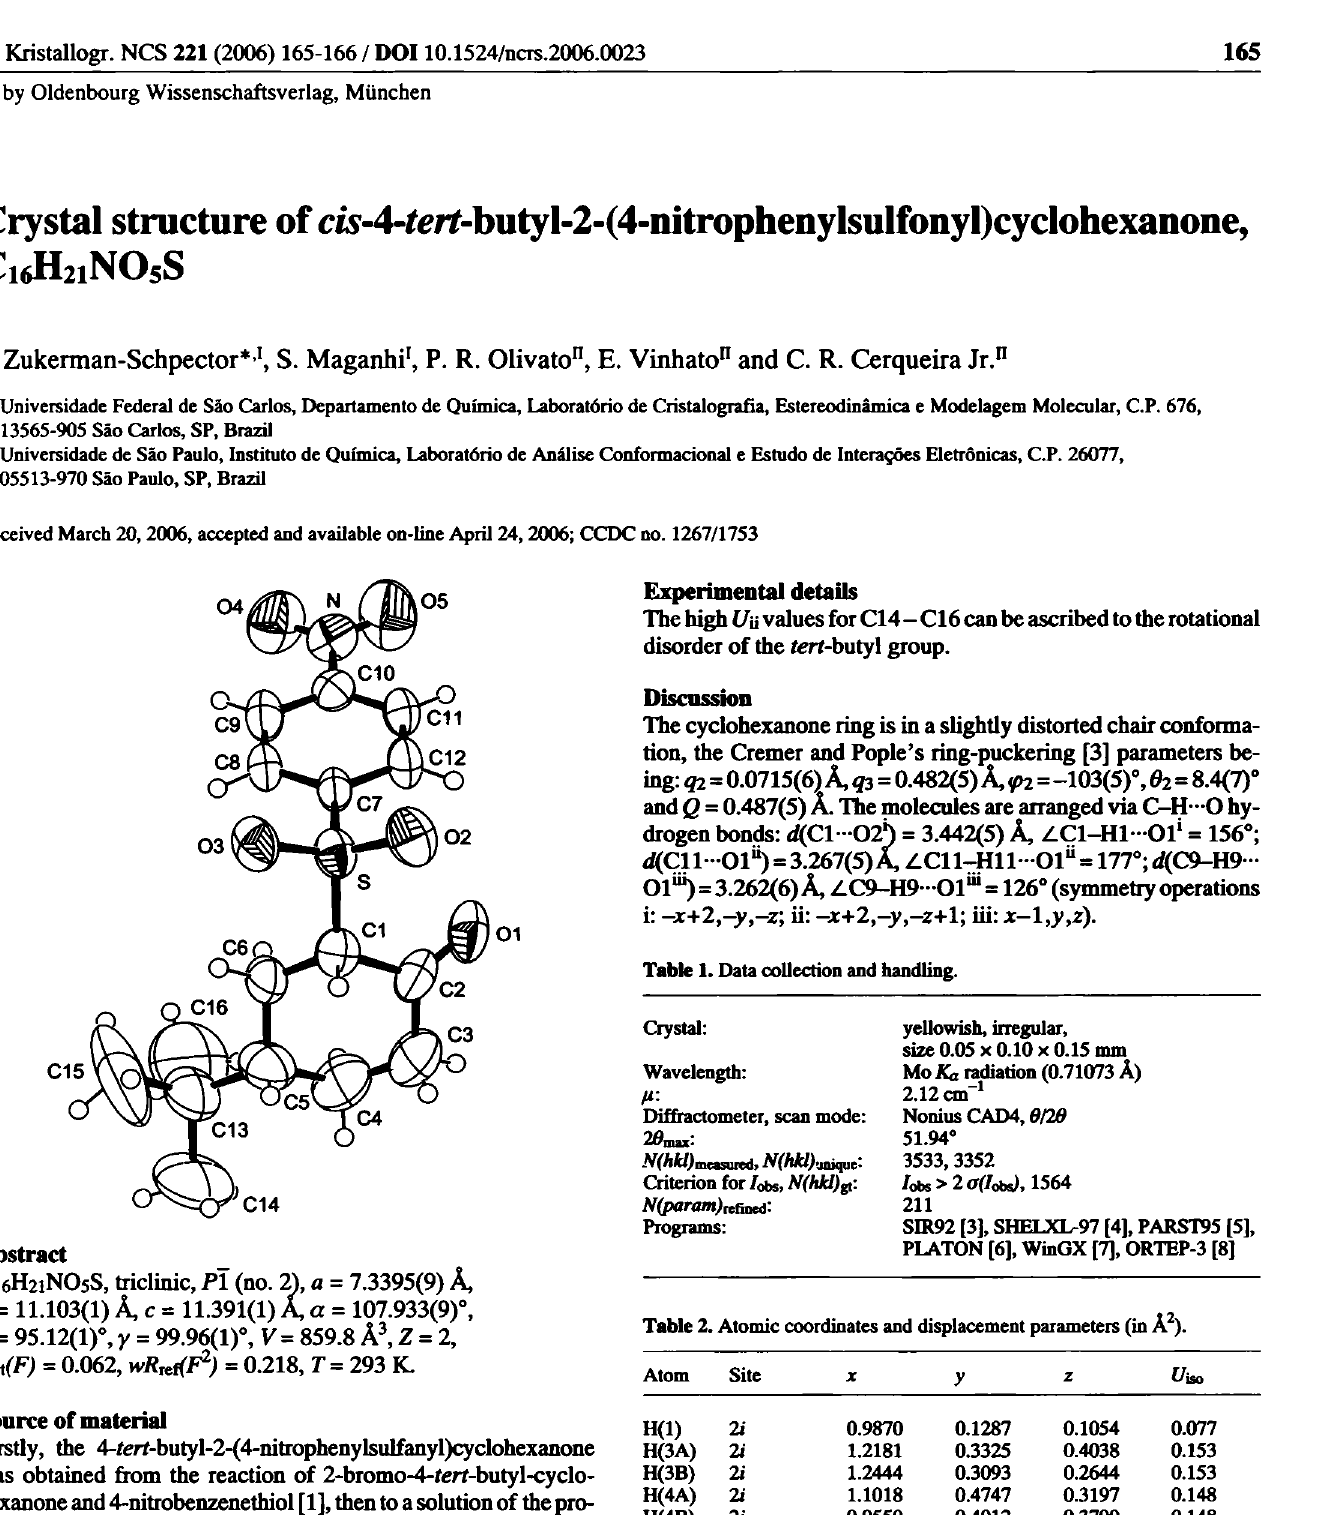
Table 2. Atomic coordinates and displacement parameters (in A 2